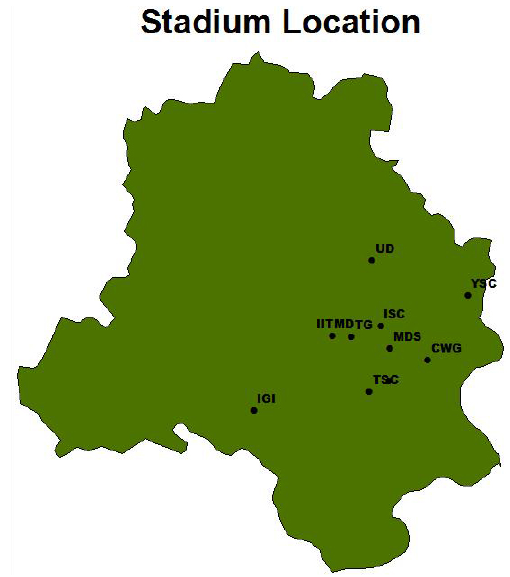
Figure 4. Locations of the monitoring stations for the Common- wealth